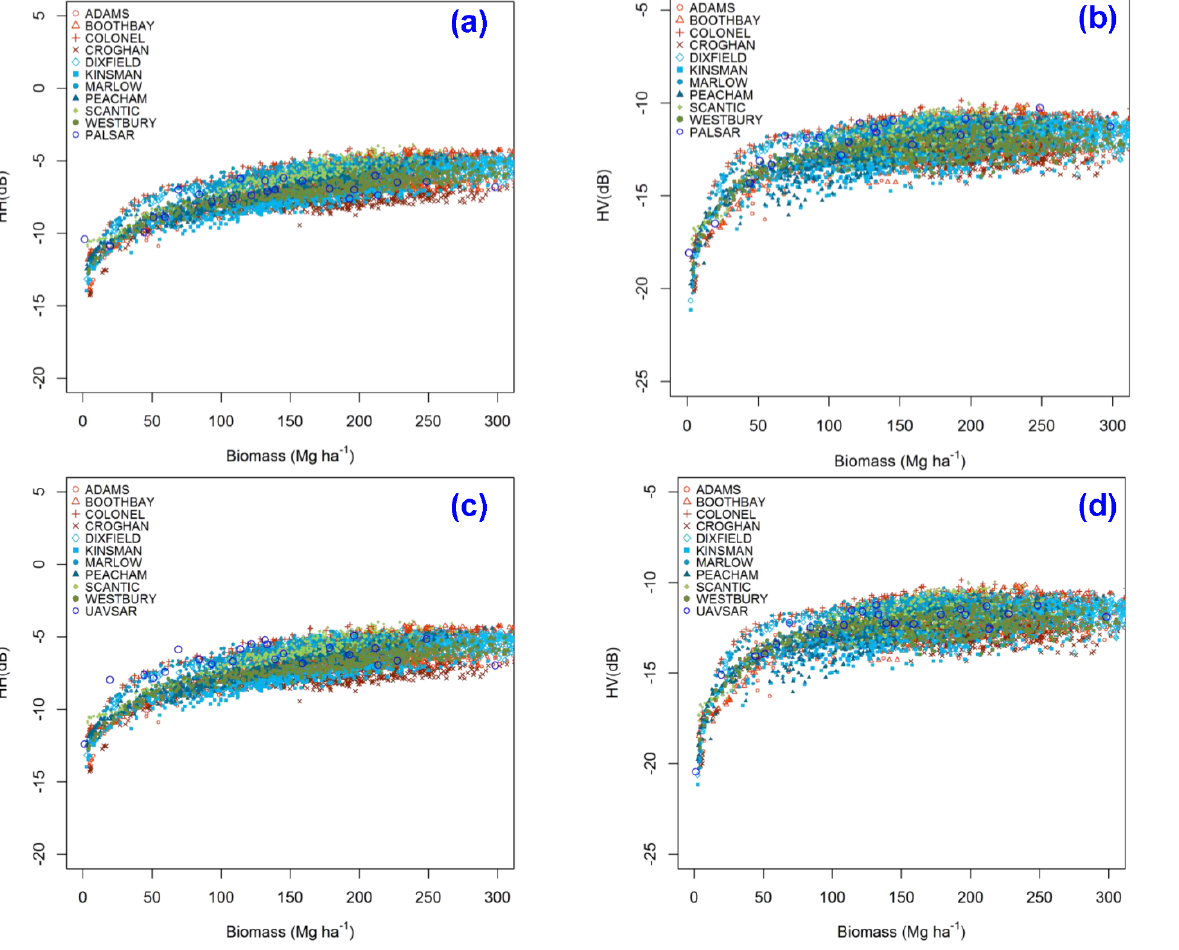
Figure 3. SAR backscatter as a function of forest aboveground biomass from model simulation and remote sensing observations. Simulations from ZELIG are plotted with ( a ) PALSAR HH, ( b ) PALSAR HV, ( c ) UAVSAR HH, and ( d ) UAVSAR HV. ADAMS-WESTBURY are the different types of soil based on drainage and taxonomic classification